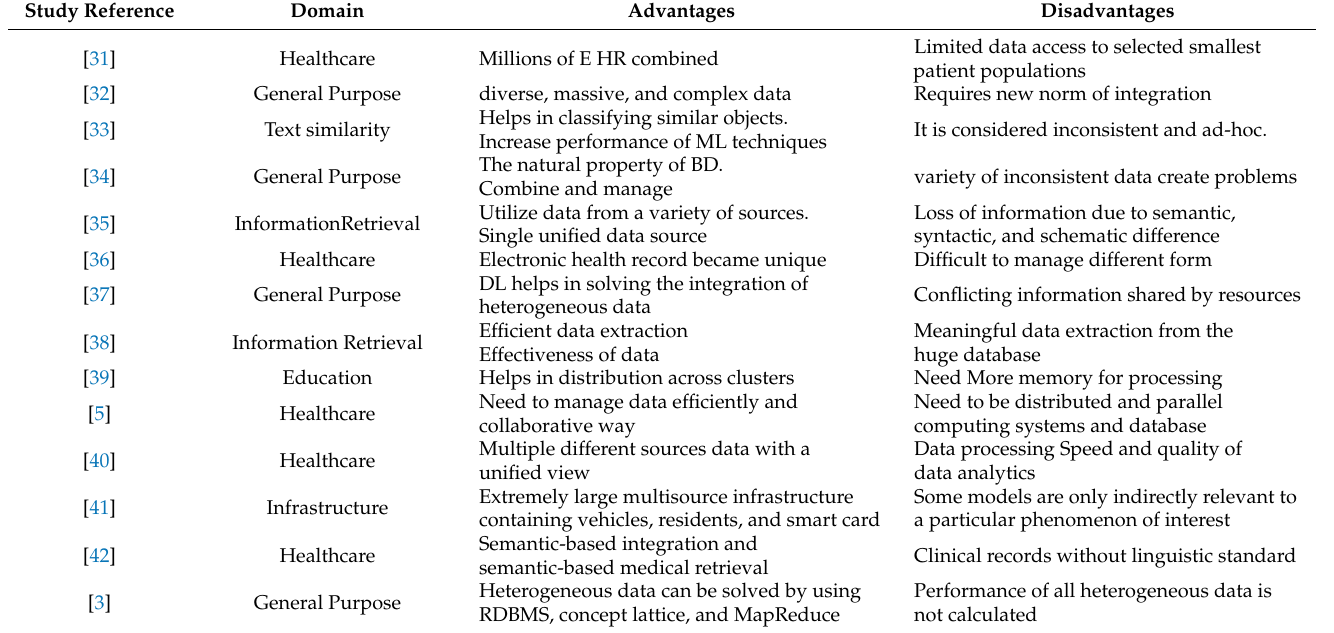
Table 6. RQ1 domains’ advantages and